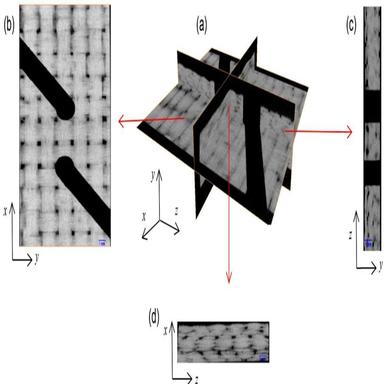
Step 1 reconstruction image: (a) Axonometric; (b) X-Z plane; (c) Y-Z plane; (d) X-Y plane.